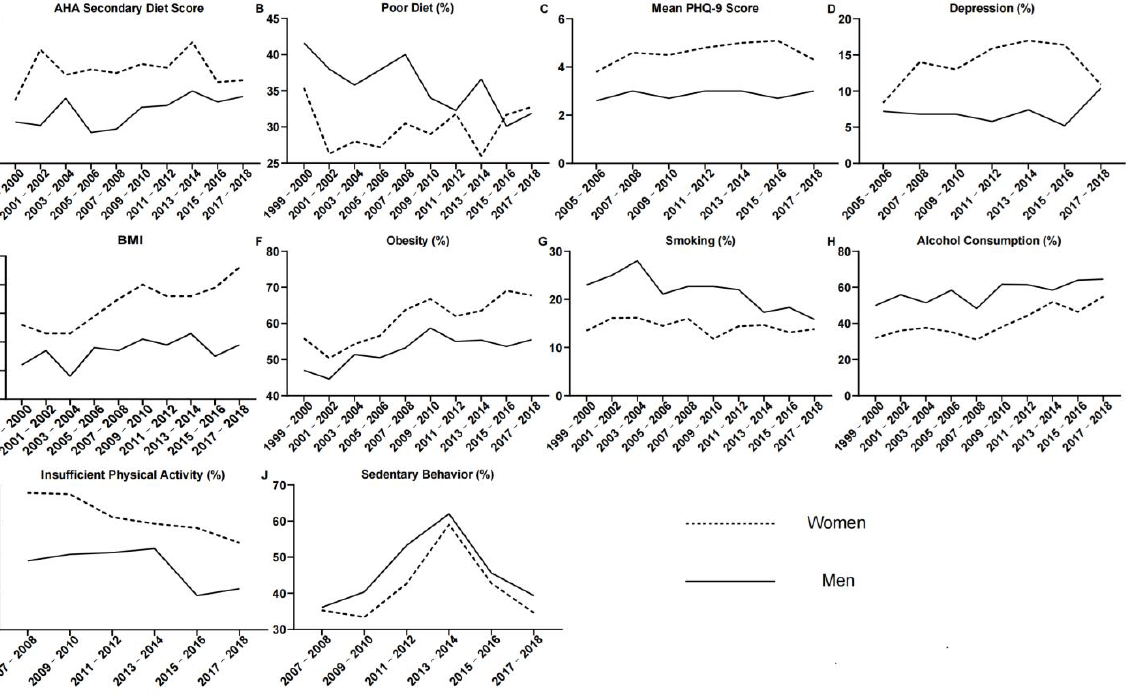
Figure 1. Trends in unhealthy lifestyle behaviors among participants of the NHANES surveys with diabetes by gender and over time. AHA: American Heart Association; PHQ-9: Patient Health Questionnaire-9; BMI: Body Mass Index.